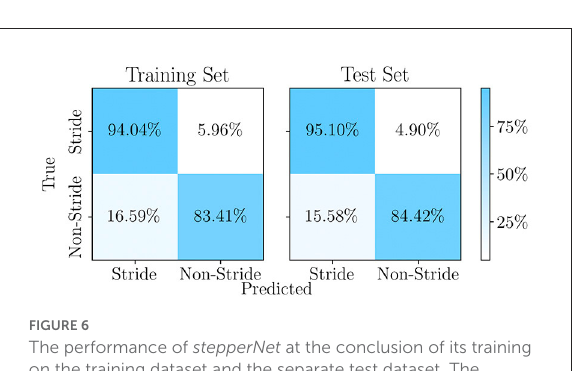
set (521 features) which was used to monitor stepperNet ’s